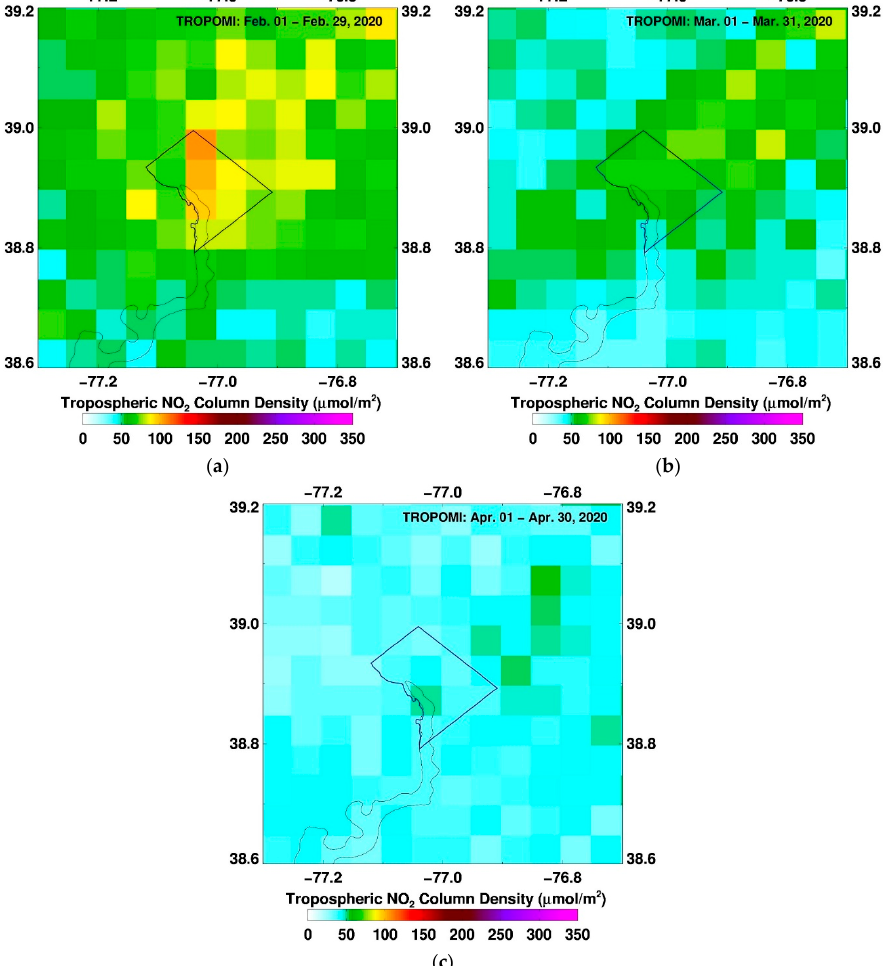
Figure 15. Distribution of NO 2 concentration in Washington DC in February ( a ), March ( b ) and April ( c ). Again, as seen in the histogram shown below (Figure 16), which is for Washington, DC, as the amount of mobility (i.e., the amount of movement from a given device) de- creases, as does the peak in the NO 2 column density. In the mobility data, April 2020 peak distance was the lowest but in the NO 2 histogram, March NO 2 concentrations were slightly lower than those in April or nearly the same.